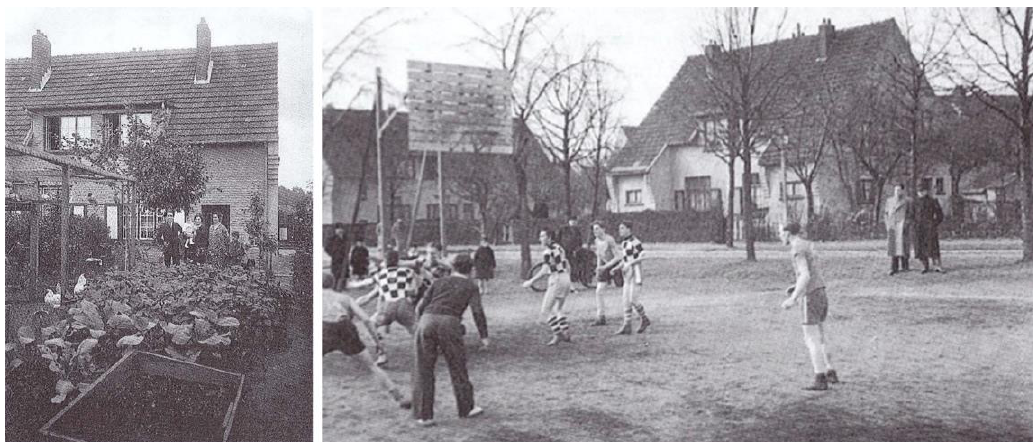
Figure 3 . Moortebeek between 1921 and 1980 (exact date unknown): private garden and sports field. Source data: Les Foyers Collectifs